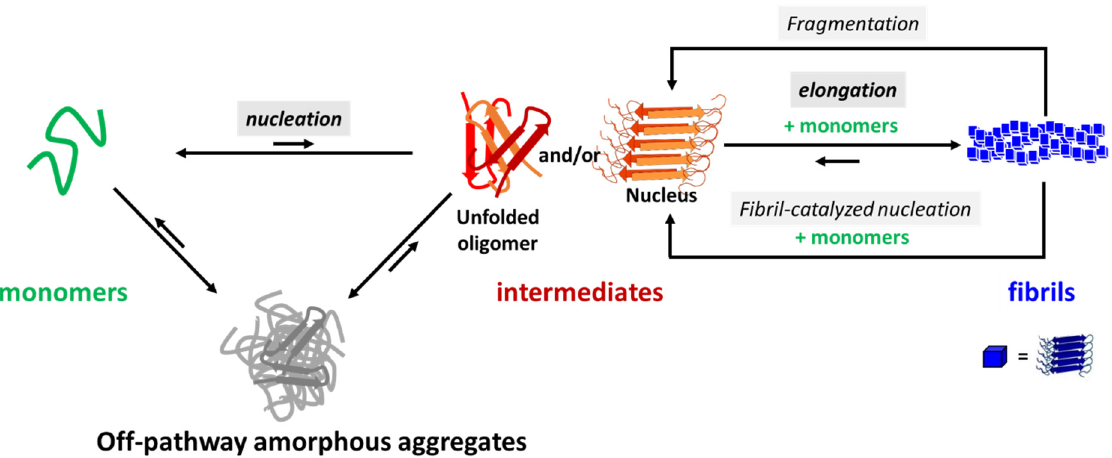
Scheme 1. Simplified scheme of the self-assembly of the A β 1–40 peptide showing nucleation, elongation and secondary nucleation steps, as well as off-pathways leading to amorphous aggregates. Elongation occurs from nuclei by the addition of monomers at their